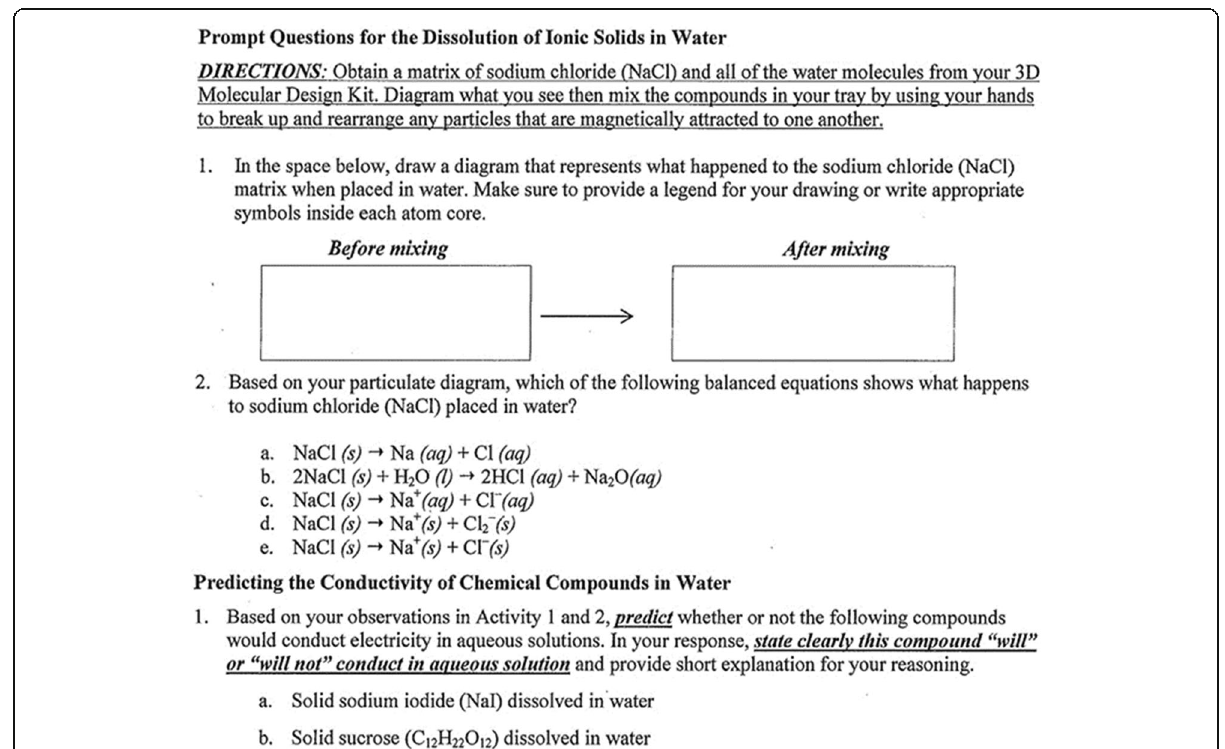
Fig. 1 Prompt questions from POGIL ChemActivity used to explore sociochemical